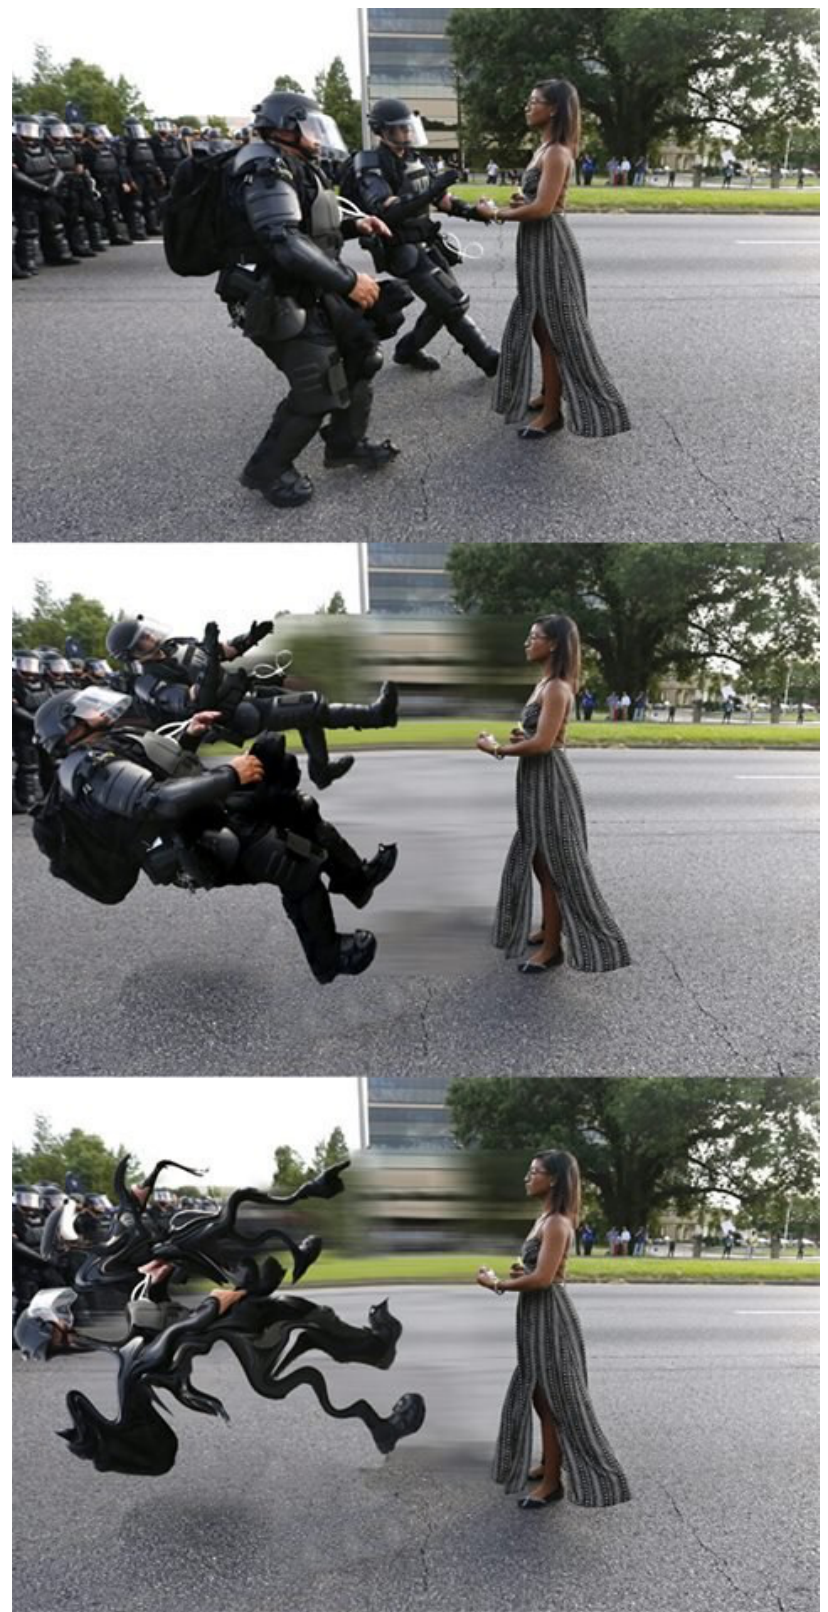
Figure 12. The police repulsed and deflated (2016). By Yvang. Picture courtesy of the artist.